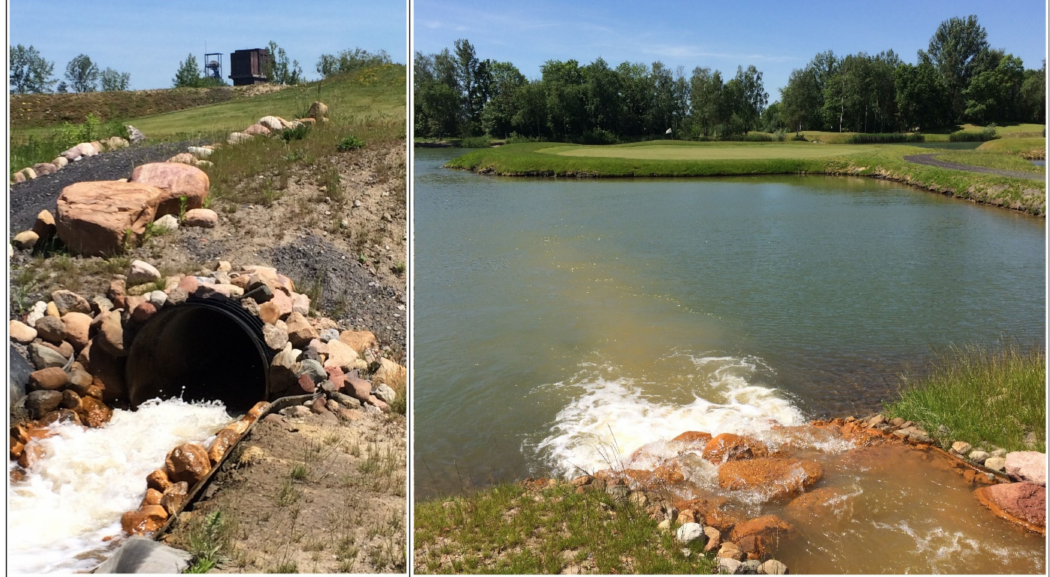
Figure 6. The pumped mine water discharge from Ewa shaft in Bytom, Poland ( left ), and its outfall into a lake within the ARMADA housing development complex ( right ). Reprinted with permission from ref. [70]. Copyright 2017 David